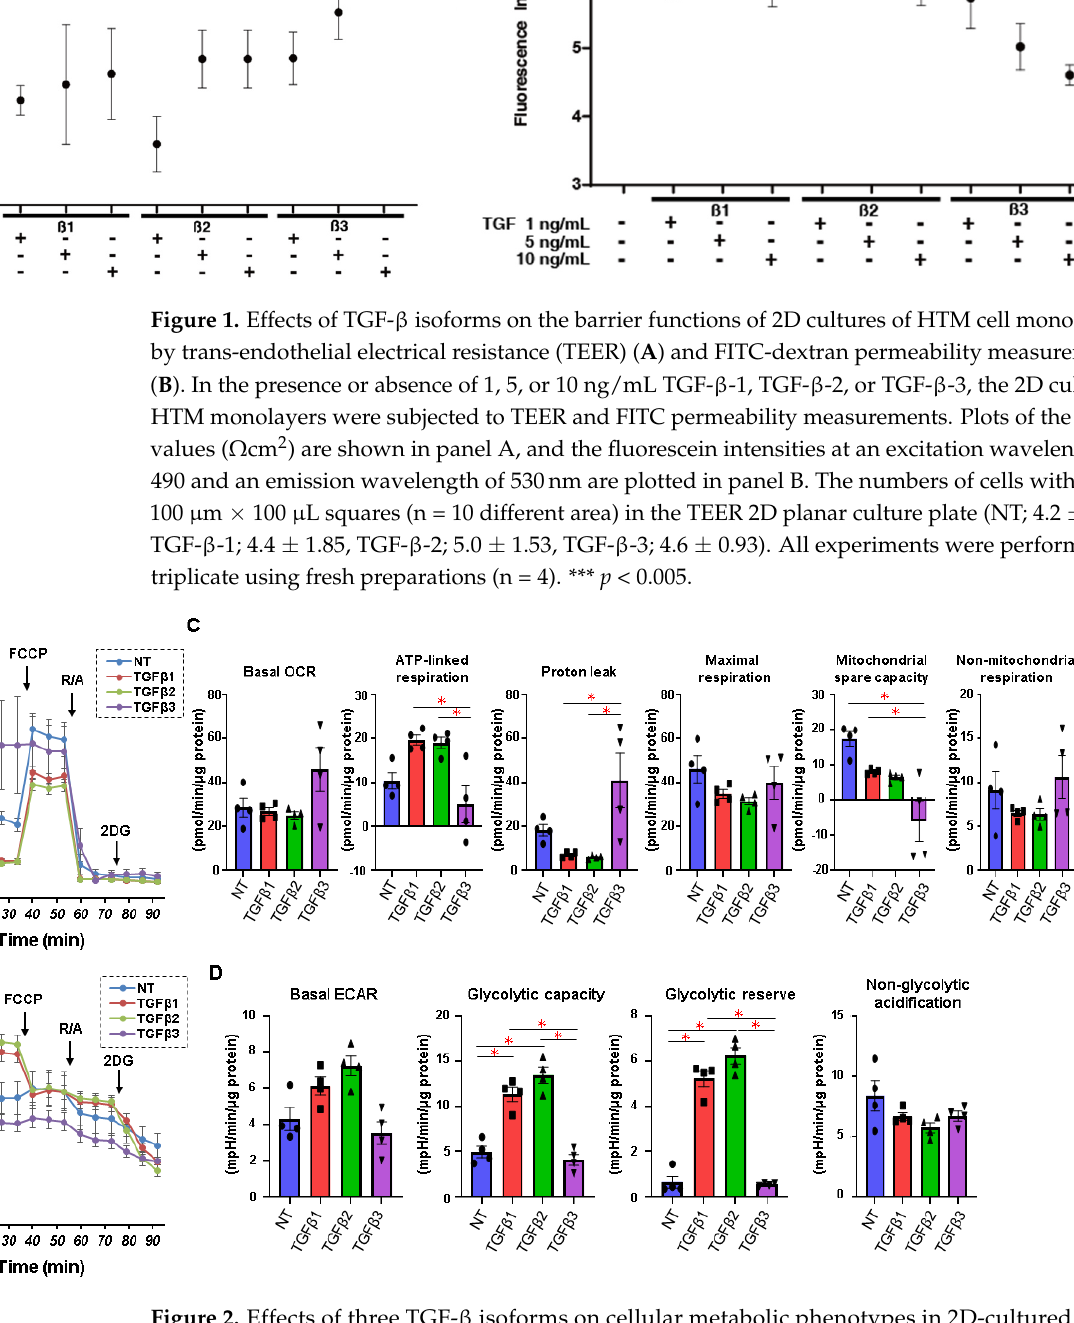
Figure 2. Effects of three TGF- β isoforms on cellular metabolic phenotypes in 2D-cultured HTM cells. At day 6, 2D-cultured HTM (NT, non-treated control) and those treated with 10 ng/mL solutions of TGF- β -1, 5 ng/mL solutions of TGF- β -2, or 1 ng/mL solutions of TGF- β -3 were subjected to a real-time metabolic function analysis using a Seahorse XFe96 Bioanalyzer. Panel ( A , B ): Simultaneous measurements of oxygen consumption rate (OCR, Panel ( A )) and